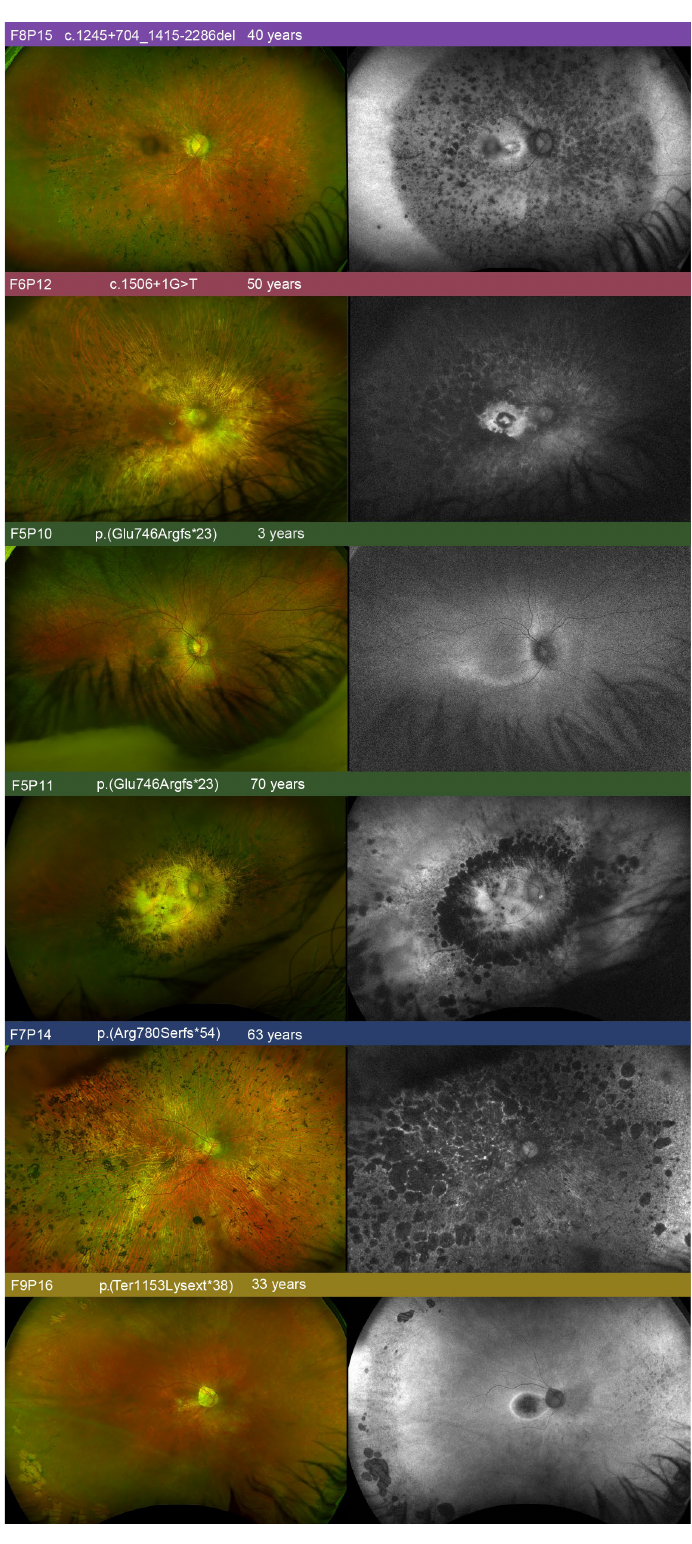
Figure 17. Wide-field (Optos) color ( left column) and FAF ( right column) fundus images. Patient ID is marked on the top of each color image together with the variant and age at the imaging. The patients are ordered by the location of the variant from the most proximal to the most distal.